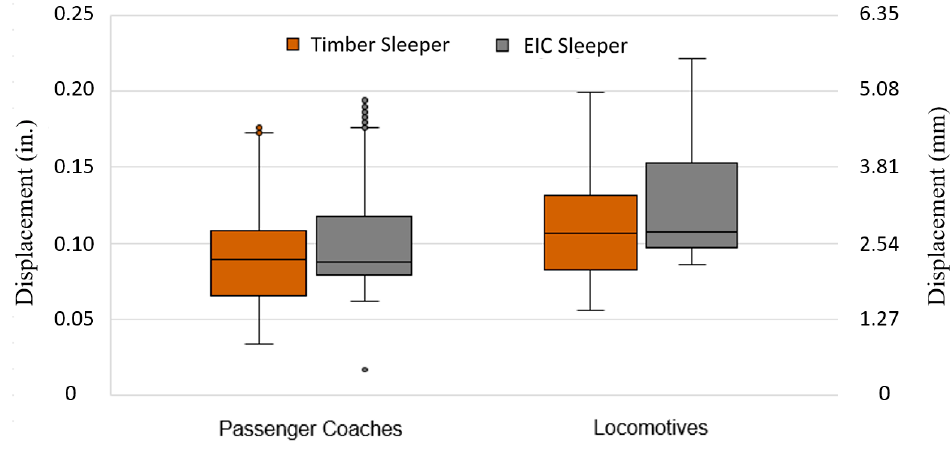
Figure 10. C omparison of the track displacement between the timber and EIC sleepers.